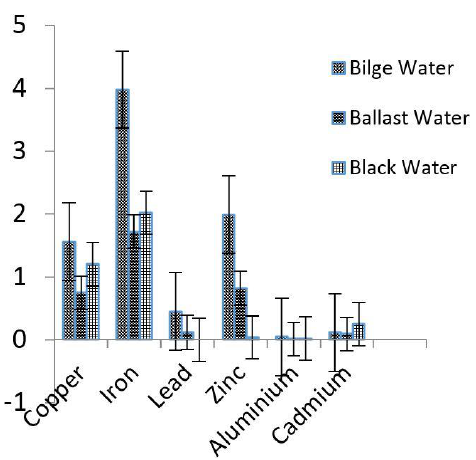
Figure 4. Distribution of the chemical parameters of shipborne wastewater.